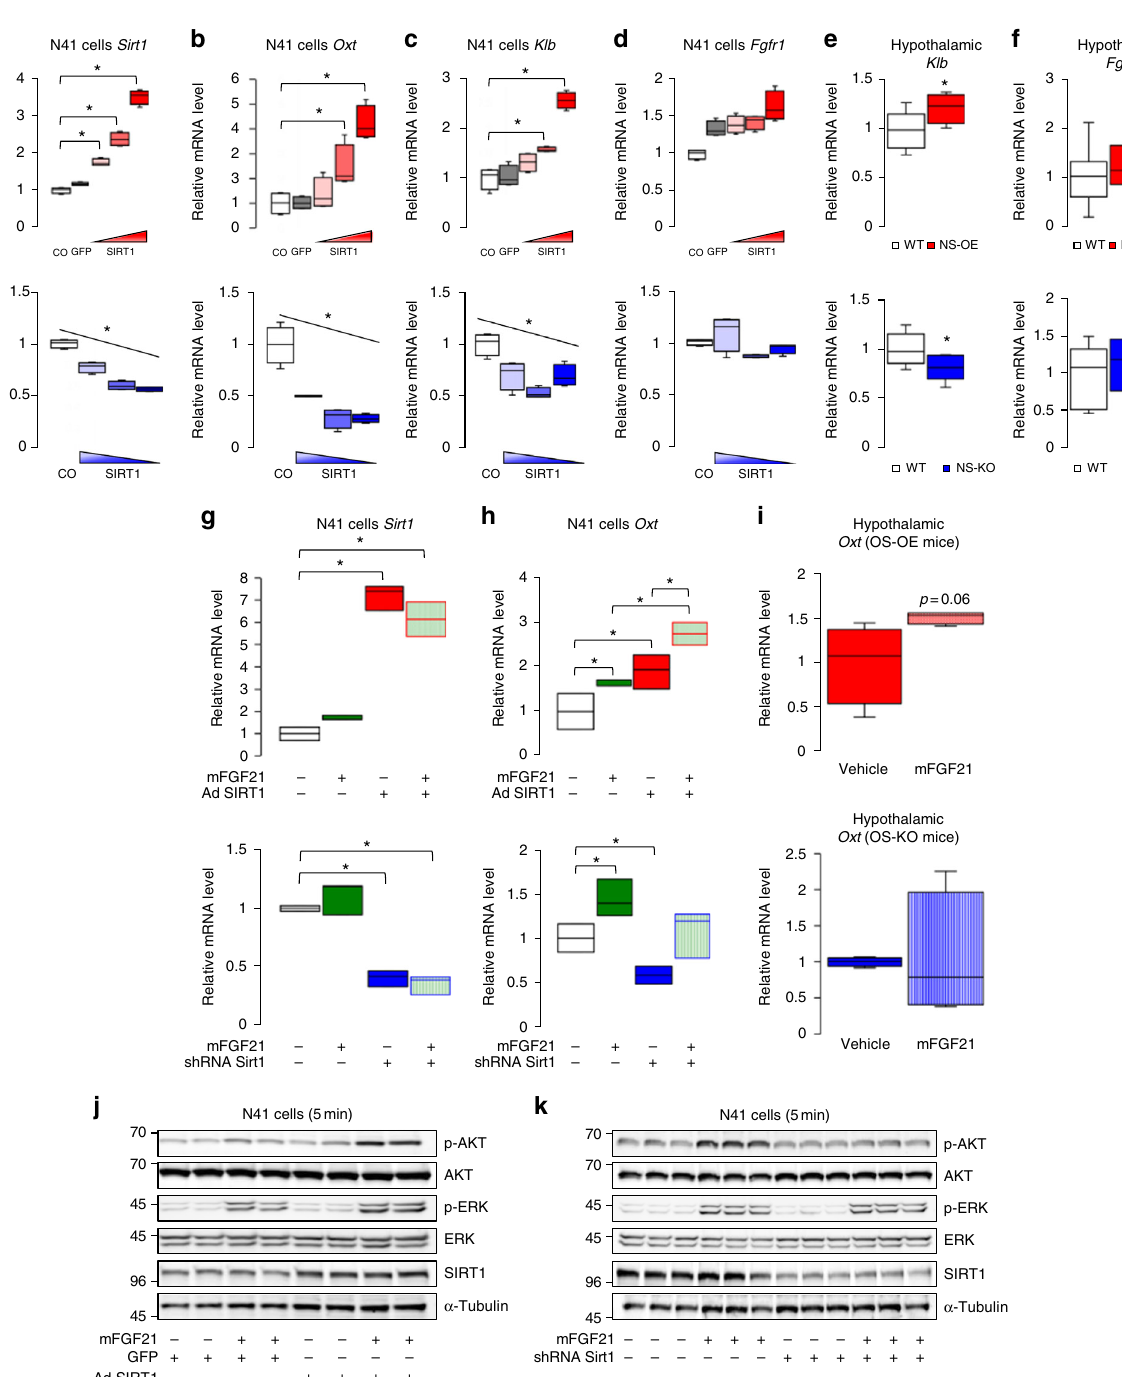
Fig. 7 SIRT1 enhances KLB-AKT signalling and promotes FGF21-induced Oxt expression. a – d Effects of Sirt1 manipulation on gene expression in hypothalamic N41 cells. Sirt1 expression was manipulated by viral vectors to different degrees. Sirt1 expression in untreated (CO), control (GFP) and viral infected cells (red, Sirt1 overexpressing; blue, Sirt1 silencing). Shading indicates low (light) to high (dark) MOIs or knockdown ef fi ciencies. Manipulating Sirt1 expression ( a ) affected expression of Oxt ( b ) and Klb ( c ), but not Fgfr1 ( d ) ( n = 4 per group). e , f Hypothalamic Klb and Fgfr1 mRNA expression in WT, NS- OE (red) and NS-KO (blue) mice ( n = 6 per group). g , h Effects of Sirt1 overexpression (top) and Sirt1 silencing (bottom) on FGF21-induced Oxt expression. N41 cells were treated with or without 100 nM mFGF21 for 8 h; expression levels of Sirt1 ( g ) and Oxt ( h ) ( n = 3 per group). i Hypothalamic Oxt mRNA expression levels in to OS-OE and OS-KO mice after IP injection of mFGF21 (1 mg/kg) or water (vehicle) ( n = 4 per group). j , k Effects of overexpressing ( j ) ( n = 2 per group) or silencing ( k ) ( n = 3 per group) Sirt1 expression on FGF21-induced intracellular signalling analysed by western blotting. After viral infection, N41 cells were incubated for 5 min in the absence or presence of 100 nM mFGF21. Data are shown as box and whisker plots (centre line, median; box limits, upper and lower quartiles; whiskers, the minimum and maximum value of a data set). * p < 0.05. Data in a – h were replicated more than three times, and data in j , k were replicated twice in the laboratory. See also Supplementary Fig.